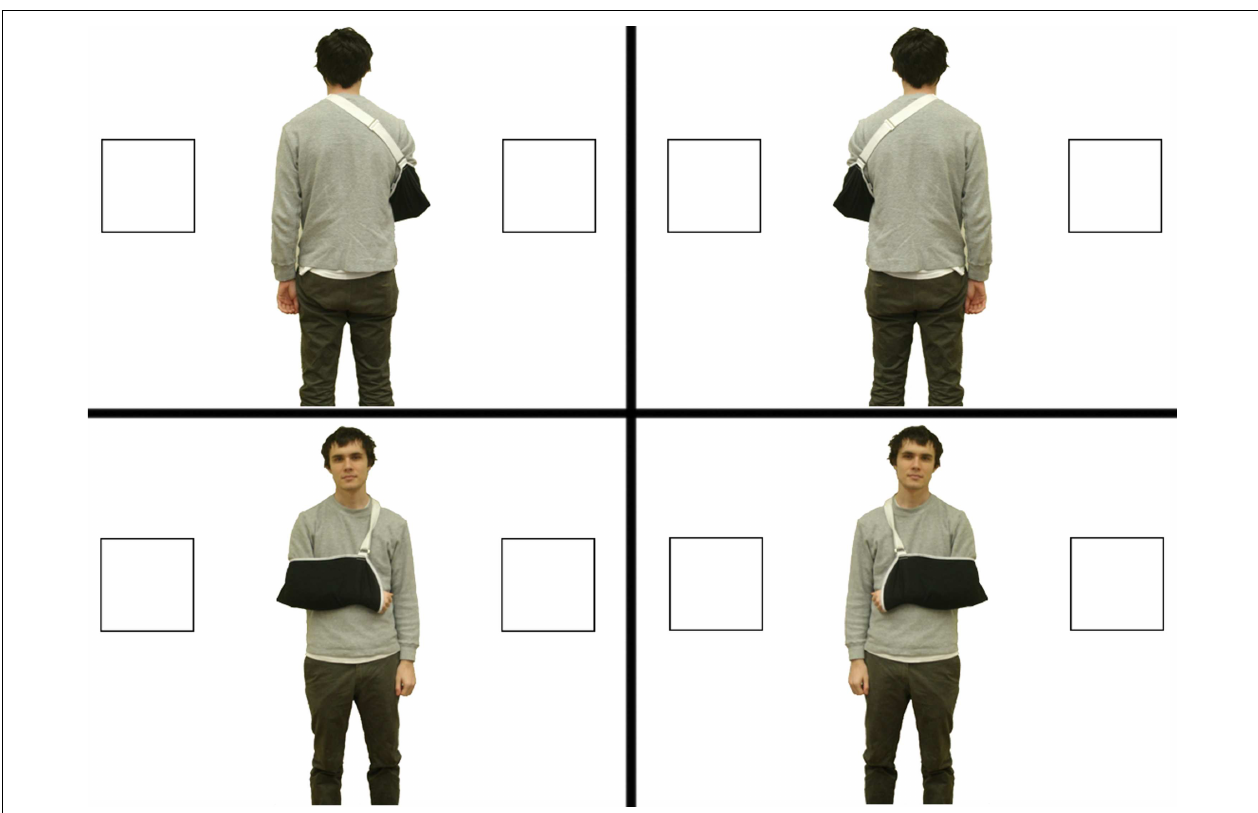
FIGURE 5 | Stimuli used in Experiment 2 . Each participant saw only one of these four images.